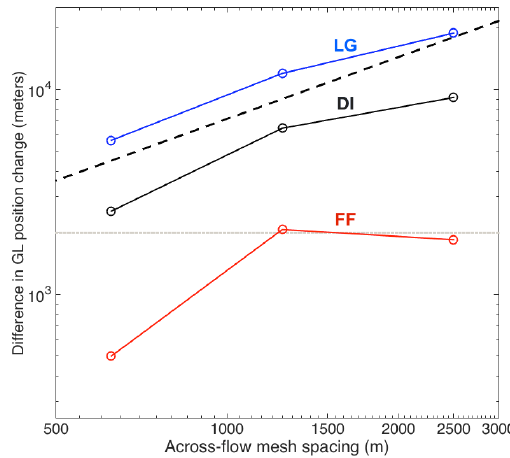
Figure 9. Difference in FELIX-S and Elmer/Ice GL position changes ( (cid:49) GL Elmer − (cid:49) GL FELIX ) at the centerline for the P75S experiment as a function of increasing across-flow ( y ) resolution (resolution increases from 2500 to 625m as N y increases from 20 to 80). Lines representing the differences relative to the LG, DI, and FF implementations in Elmer/Ice are labeled. The black dashed line shows the slope for a theoretical first-order convergence rate. The grey dashed line shows the estimated Elmer/Ice truncation error of ∼ 2km from Durand et al. (2009b) and Gagliardini et al.